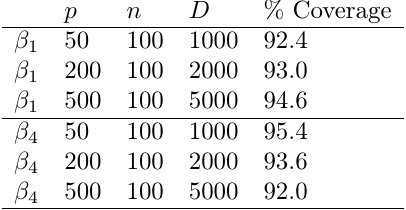
Table 2. Empirical coverage probability (Coverage %) of a 95% confidence interval for β 1 and β 4 based on CTLP over 500 simulations in (3.1), where p, n, D represent the number of predictors, the sample size, and the Monte Carlo size,